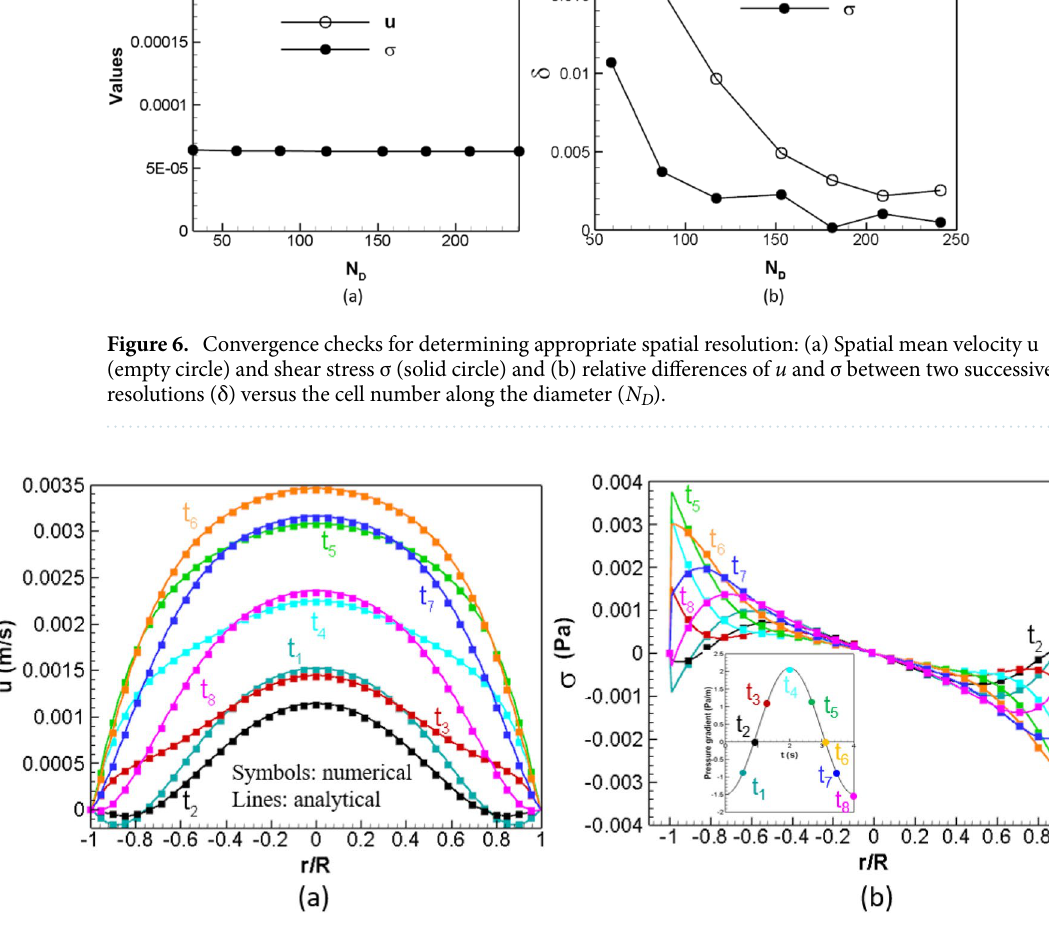
Figure 7. Comparisons of numerical results (symbols) and analytical solutions (lines) at 8 representative time instants, shown in the embedded plot, in a pulsation for velocity u (a) and shear stress σ (b) , respectively. The Womersley number α and the base flow Reynolds number Re 0 of the flow are 6.89 and 9.4, respectively.